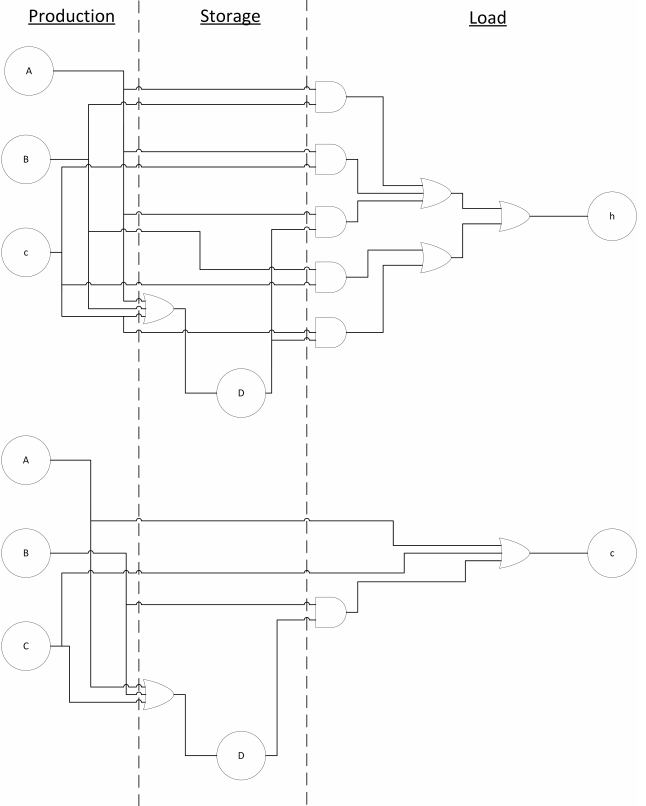
Figure 4. P-graph approach representing Equations (1) and (2) for the heating and cooling scenario,